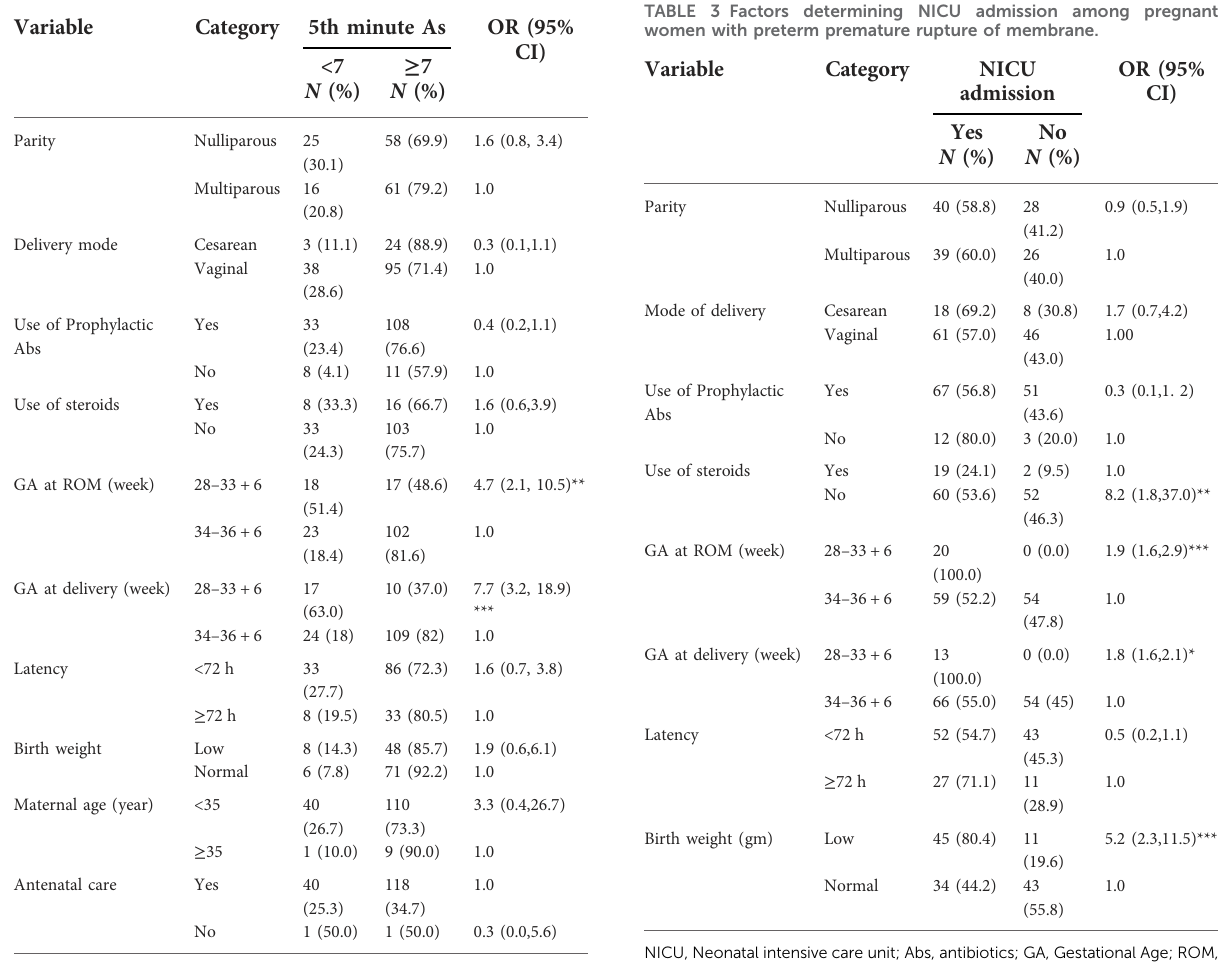
TABLE 2 Factors determining the Low 5th Minute Apgar score among pregnant women with preterm premature rupture of membrane.